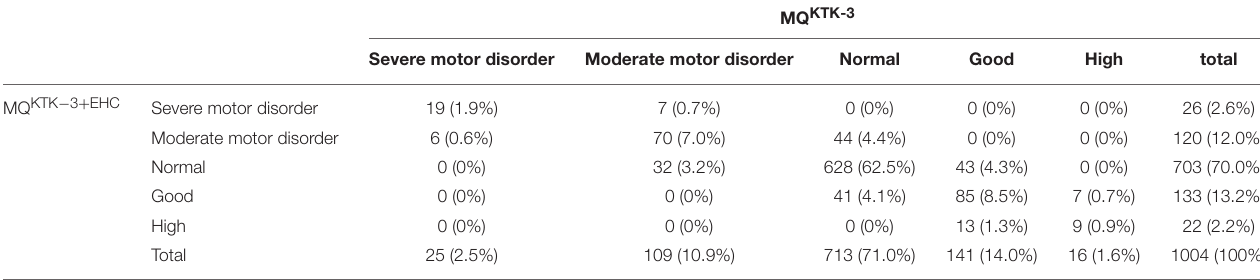
TABLE 4 | Agreement between the classification of motor abilities using the MQ KTK − 3 and MQ KTK − 3 + EHC .